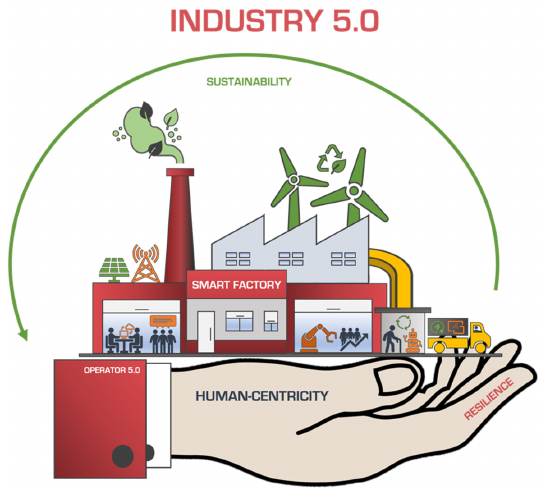
Figure 6. Schematic representation of the human-centricity at the control of smart factories in the era of Industry 5.0.